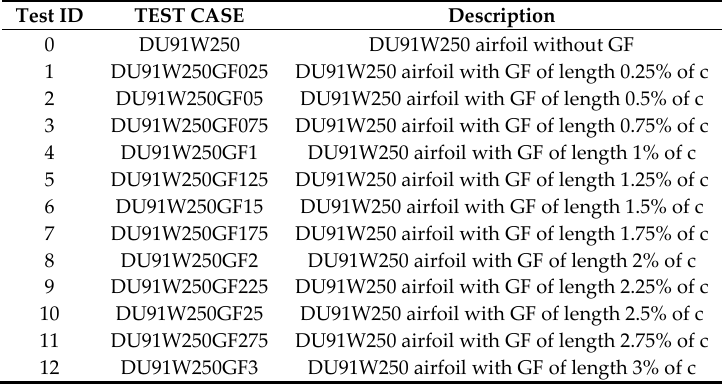
Table 1. Test cases